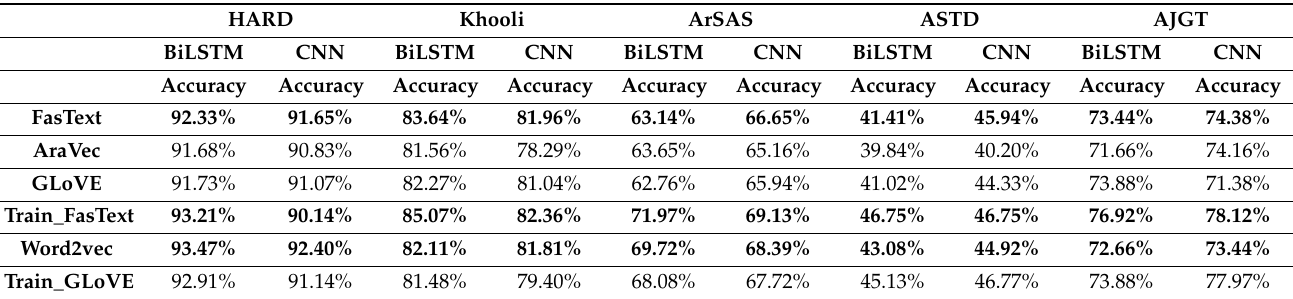
Table 8. Accuracy of trained embeddings